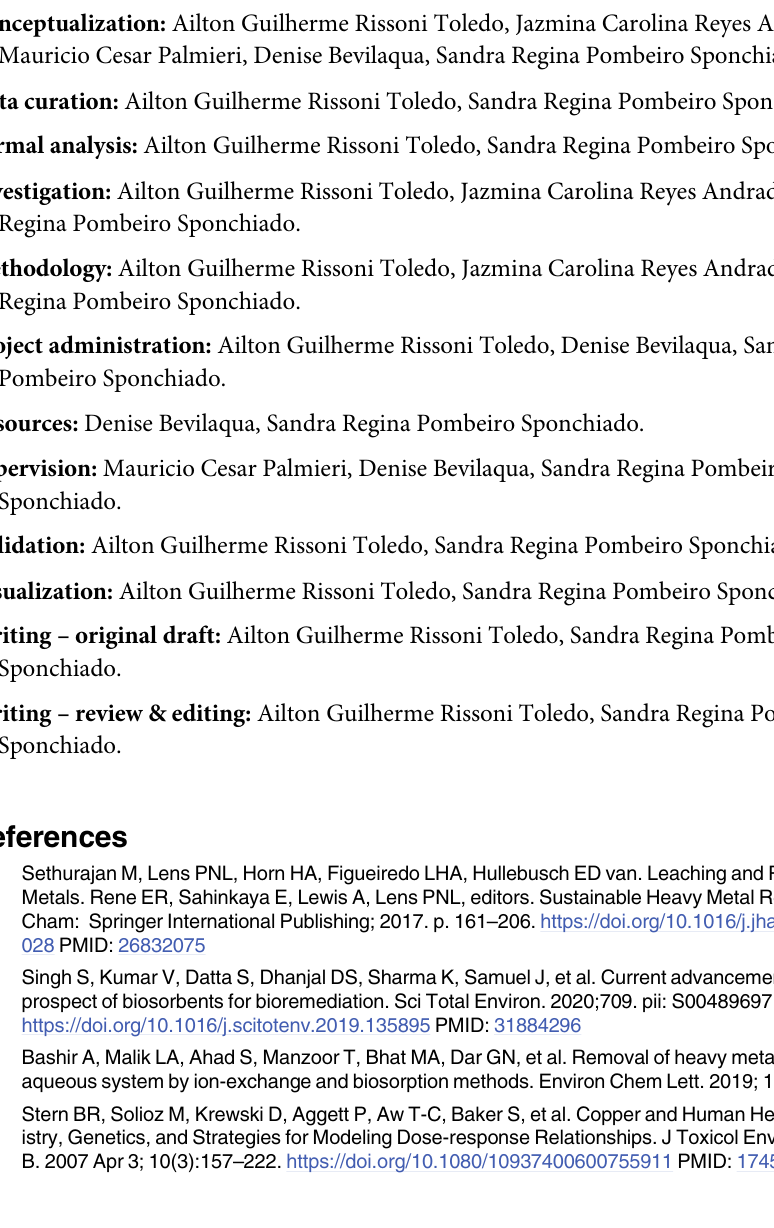
S4 Table. Biosorption (q) and desorption (q by the encapsulated biosorbent (EB30) as a function of successive